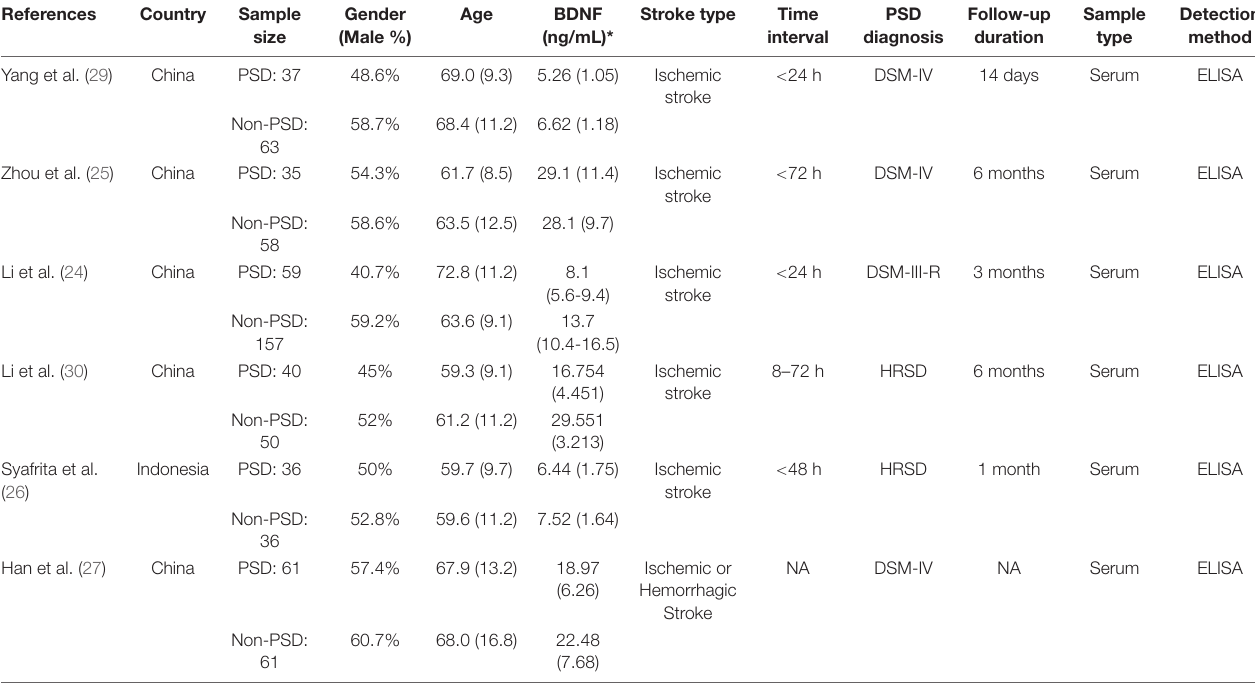
TABLE 1 | Study characteristics of included